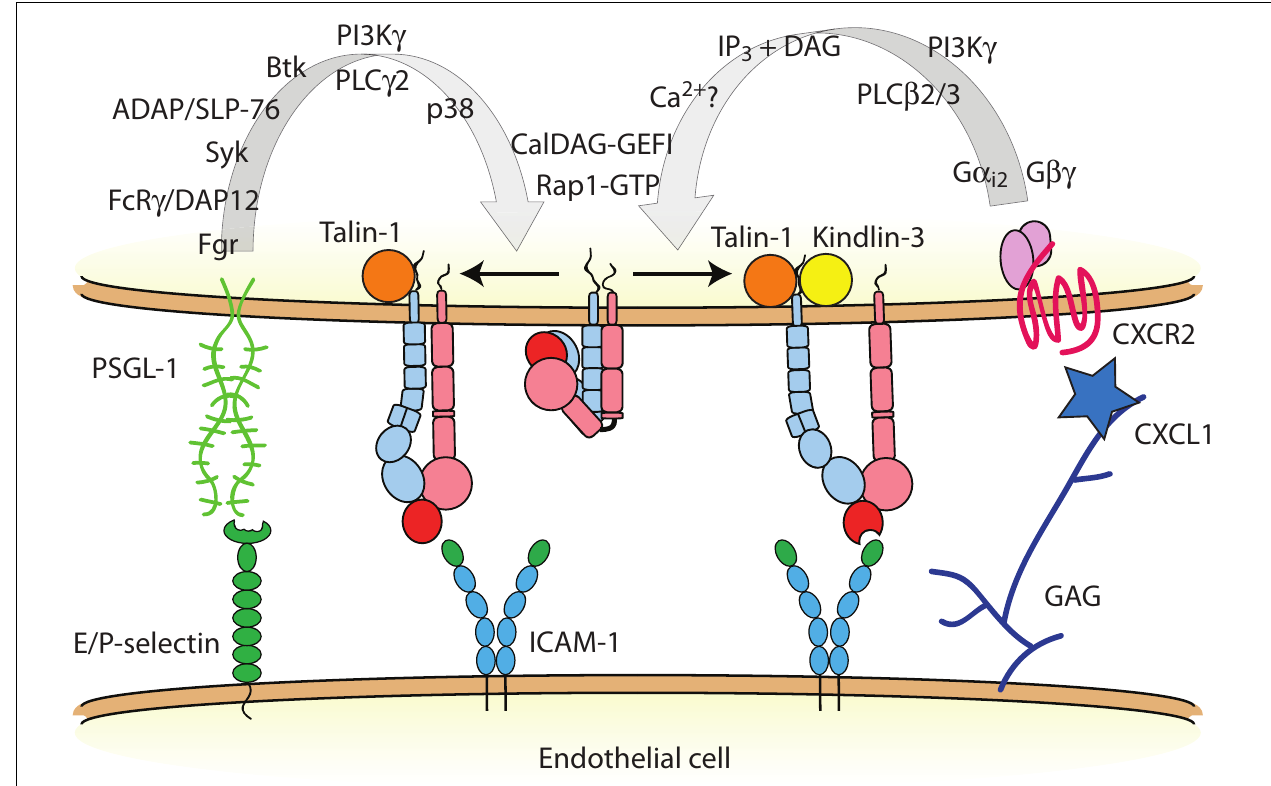
FIGURE 2 | Neutrophil inside-out activation of LFA-1. Two distinct signal transduction pathways modulate LFA-1 activation in neutrophils: (1) selectin binding to PSGL-1, and (2) chemokine receptor engagement. PSGL-1 signals talin-1-dependent LFA-1 extension, whereas chemokine GPCRs signal LFA-1 activation to a high affinity state that requires both talin-1 and Kindlin-3. Some of these signaling molecules may exist in preformed modules to facilitate rapid integrin activation. Abbreviations: Fgr, feline Gardner–Rasheed sarcoma kinase; FcR γ , immunoglobulin gamma Fc receptor; DAP12, DNAX activating